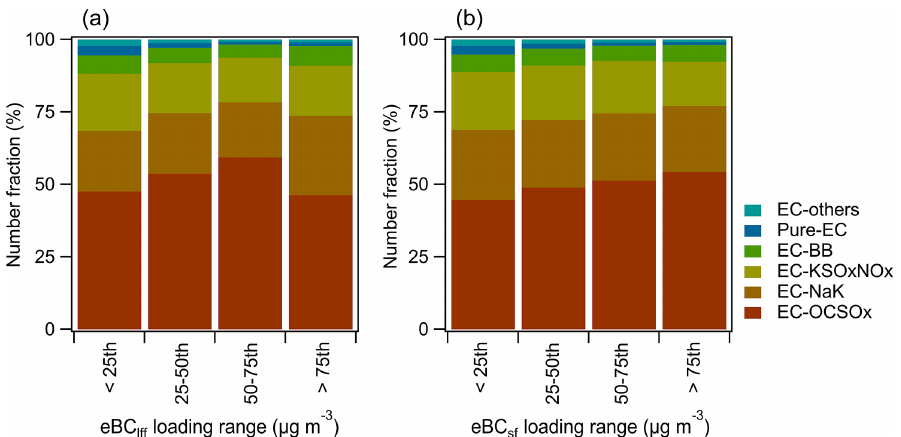
Figure 9. Number fractions of elemental carbon (EC)-containing particle classes at different loading ranges of equivalent black carbon (eBC) from sources of (a) liquid fossil fuels (eBC lff ) and (b) solid fuels (eBC sf ). The 25, 50, and 75 denote the 25%, 50%, and 75% percentiles,